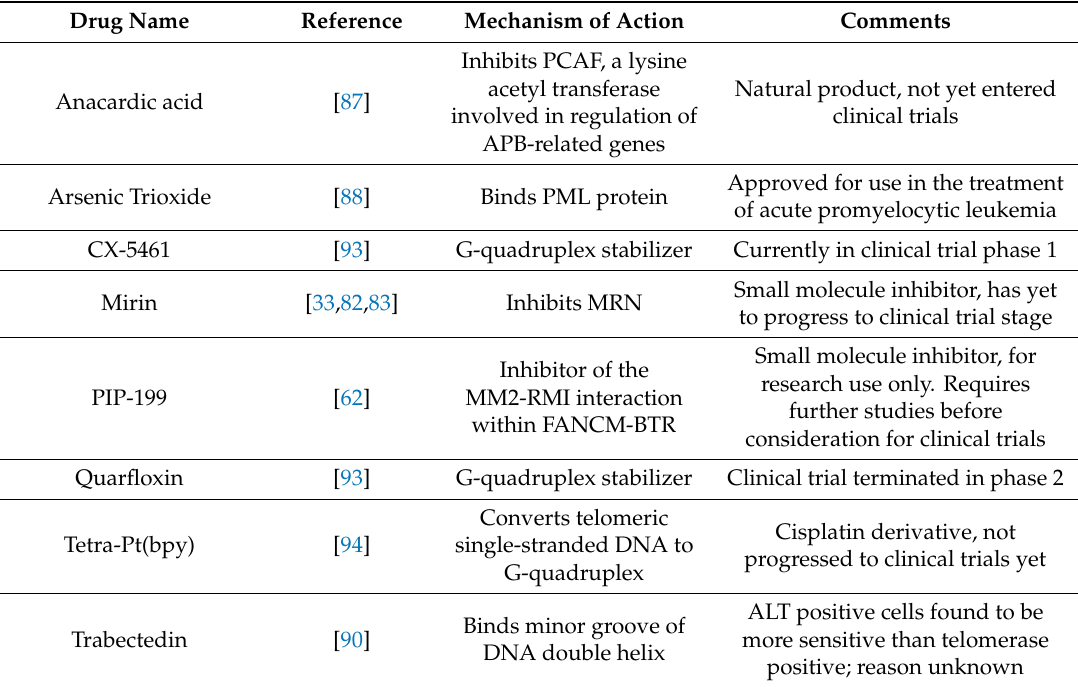
Table 1. Potential ALT-targeted